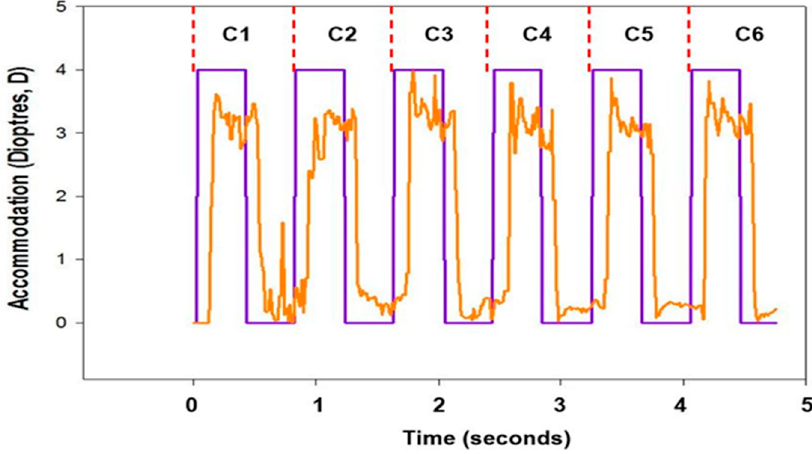
Figure 3. The accommodative response of a 27-year-old participant (yellow line), over six cycles of accommodative demand flipping between 0 D and 4 D (purple line).